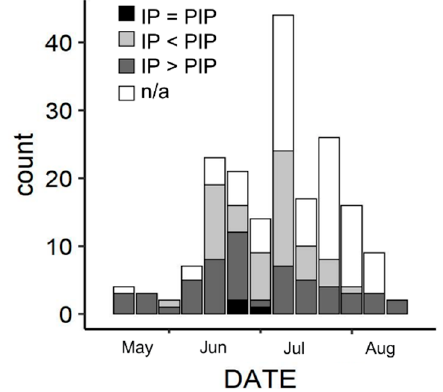
Figure 3. Temporal distribution of loggerhead turtle nesting date (DATE) in Sicily ( n = 188). IP: incubation period; PIP, IP potentially producing and equal number of males and females; n/a, IP not available